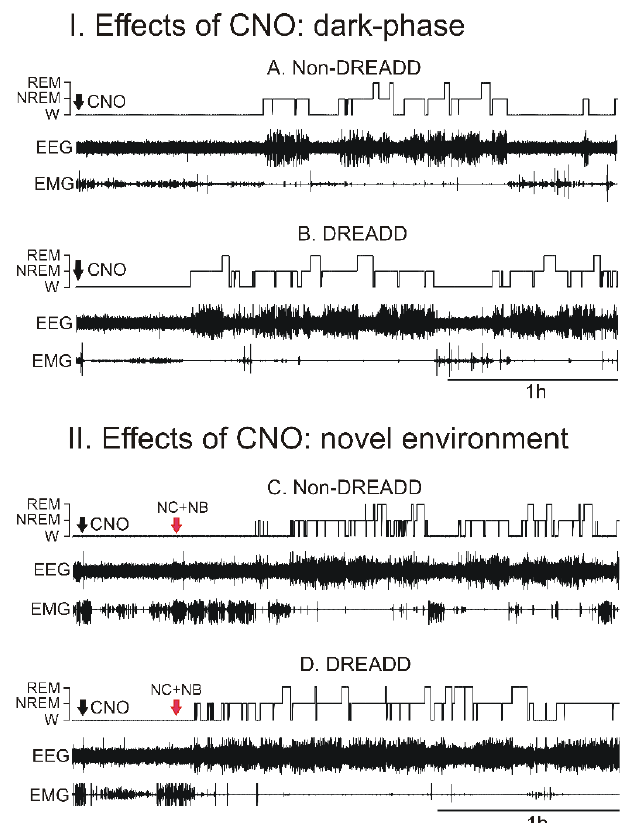
Figure 2. Effects of the chemoactivation of VLPO > PF-HA PRJ neurons on sleep-waking during the dark phase and after exposure to a novel environment during the light phase . Examples of continuous EEG and EMG tracings showing the sleep–wake profiles of animals after 1.0 mg/kg CNO treatments (black arrowhead) in the non-DREADD control and the DREADD group of rats during the dark phase and after placing them in a new cage with new bedding materials (red arrowhead). The CNO-treated DREADD rats entered into sleep relatively quickly and spent more time sleeping, both during the dark phase and the after cage and bedding change. NC + NB, new cage + new bedding material.